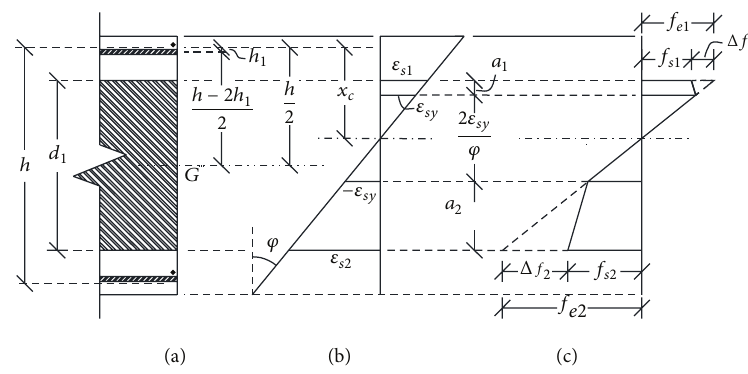
Figure 5: Strains and stresses of uniformly distributed secondary